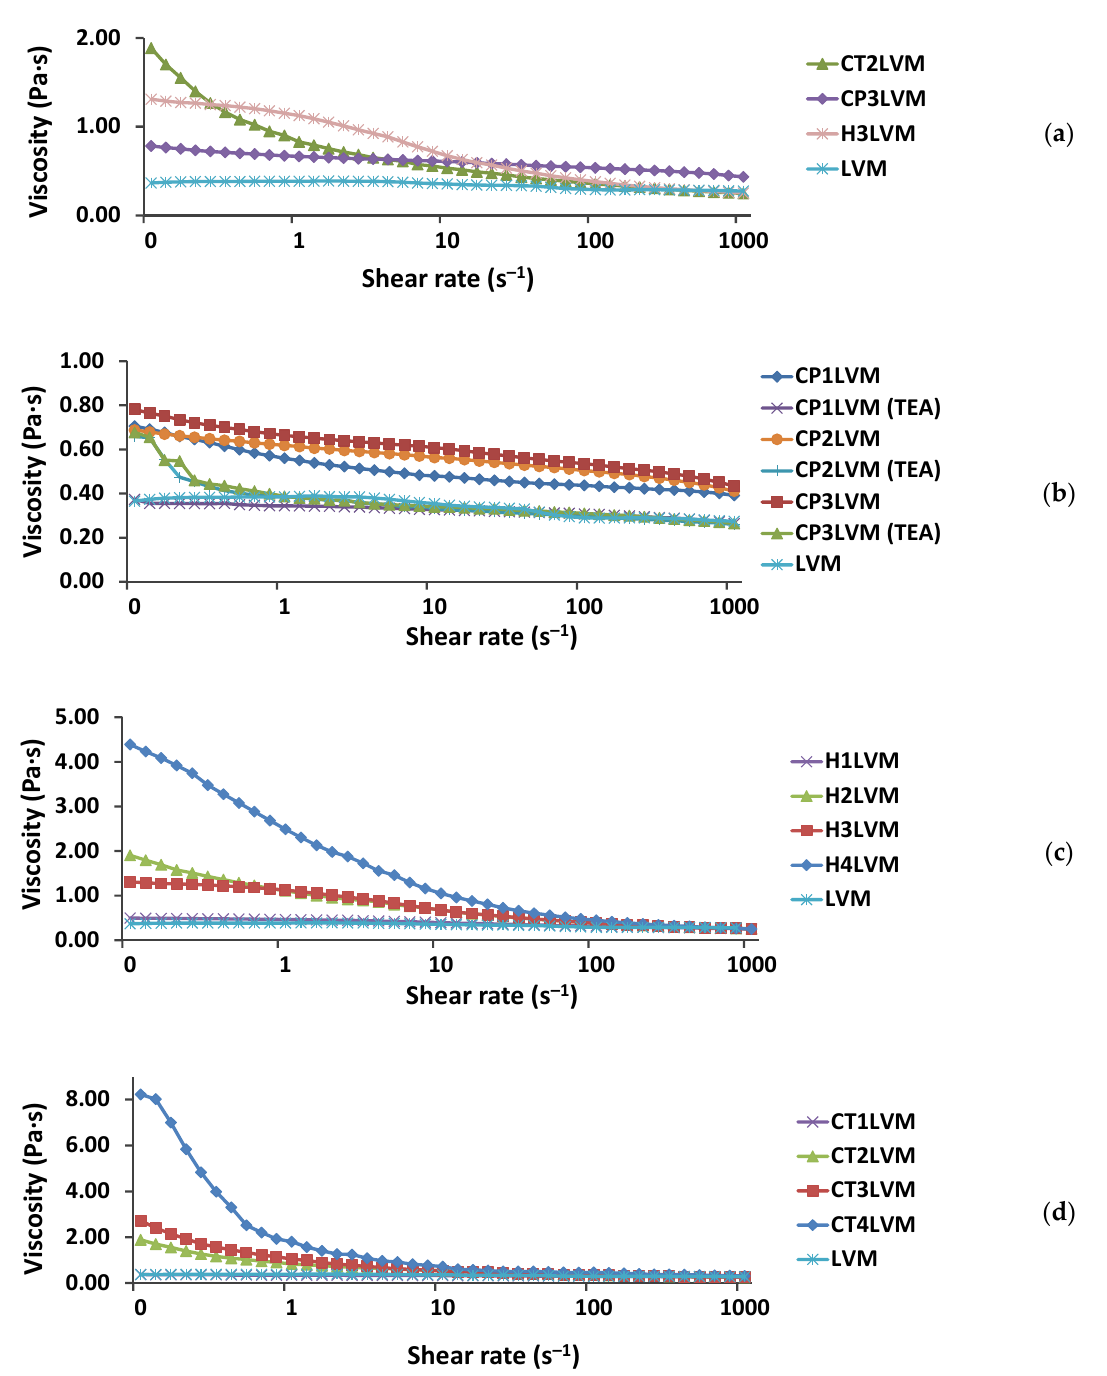
Figure 3. Flow curves for LVM microemulsion and gel microemulsions obtained with: ( a ) mass concentration of approxi- mately 0.2% thickening agent; ( b ) Carbopol ® 980 NF (“TEA” for gel microemulsions neutralized with triethanolamine); ( c ) hyaluronic acid salt; ( d )